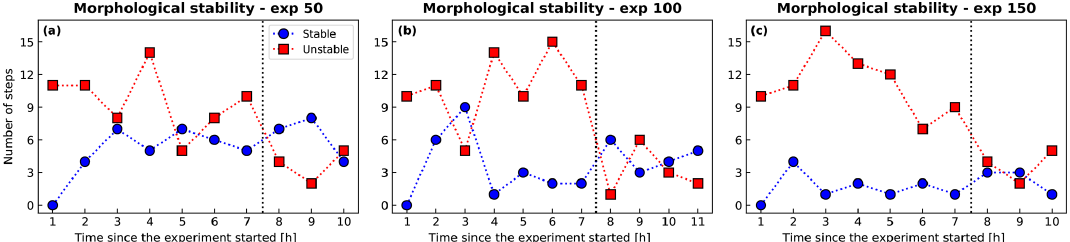
Figure 8. Stability of the step-pool morphology in time expressed as comparison between number of steps that formed and destroyed (i.e., unstable in red squares) and number of steps that remained the same or expanded/contracted (i.e., stable in blue circles) in (a) Experiment 50, (b) Experiment 100, and (c) Experiment 150. The vertical dashed line separates the feed periods (on the left) from the no-feed periods (on the right).